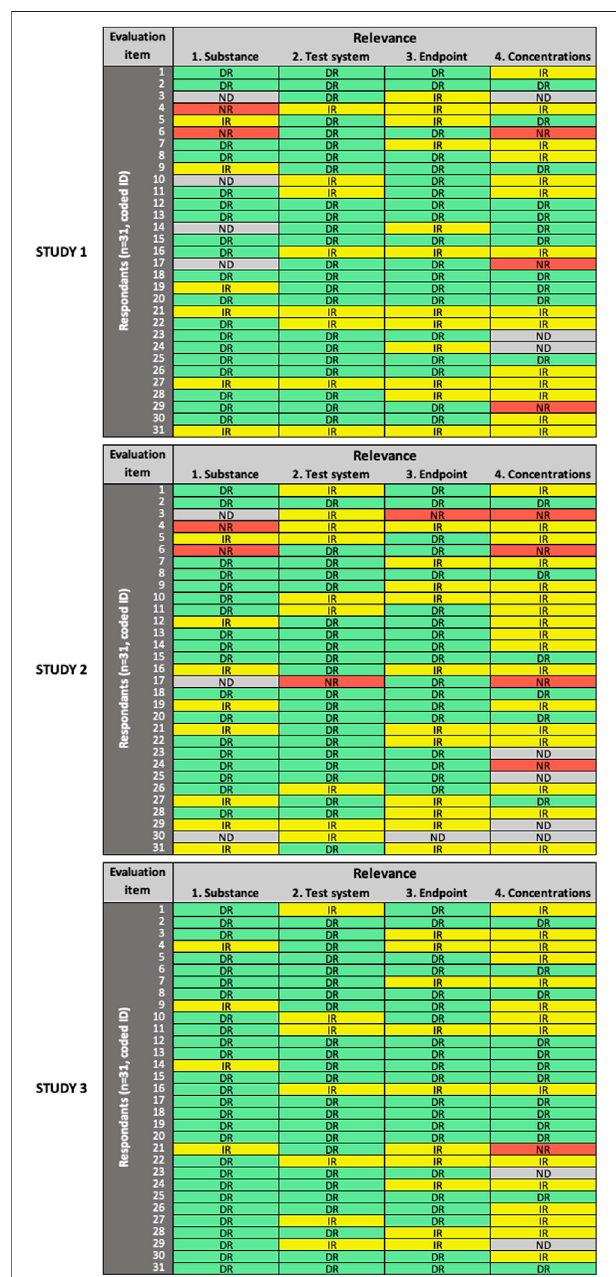
FIGURE 3 | Results of the expert test round evaluations of the relevance of the three in vitro studies ( n (cid:1) 31 participants). Each row represents the evaluation by one participant; columns represent individual items. Green cells indicate items judged as “ directly relevant ” (DR) , yellow cells indicate items judged as “ indirectly relevant ” (IR) , red cells indicate items judged as “ not relevant ” (NR) , grey cells indicate items left as “ not determined ” (ND) .